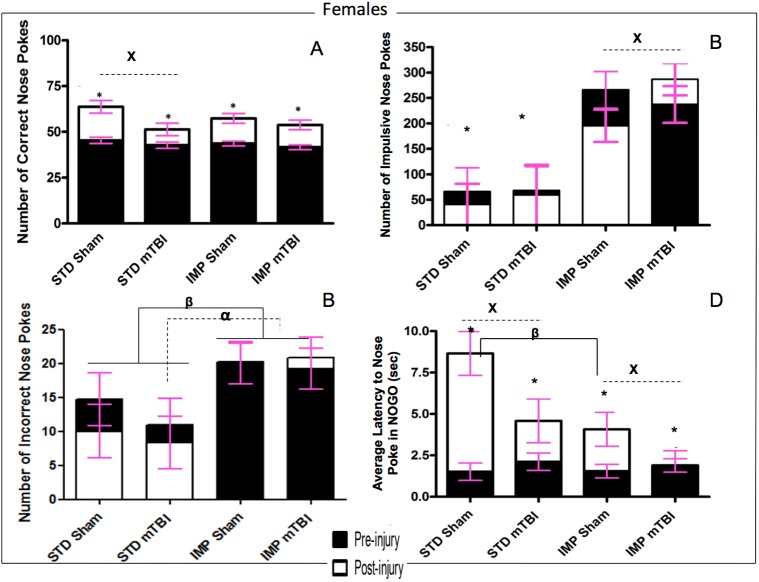
Graphical representation of Go/No-Go results.A) Accuracy, B) Impulsivity, C) Inaccuracy, and D) Response Inhibition, for female animals from the STD and IMP cohorts at the pre-injury (black bars) and post-injury (white bars) test sessions. Overall accuracy increased across all cohorts from the pre-injury session to the post-injury session, but the magnitude of change was greater for sham animals. Similar to males, the STD cohort exhibited a reduction in incorrect nose pokes with increased training but animals in the IMP cohort did not exhibit a change in the number of incorrect nose pokes. STD females exhibited significantly fewer impulsive nose pokes than IMP females at both time points. Finally, also like males, all animals except IMP-mTBIs demonstrated improvements in latency to nose poke on the NOGO trials, but the magnitude was greatest for the STD-shams (α significant effect of IMP at pre-injury, β significant effect of IMP at post-injury, x significant effect of mTBI, * significant effect of testing period, all p < .05).